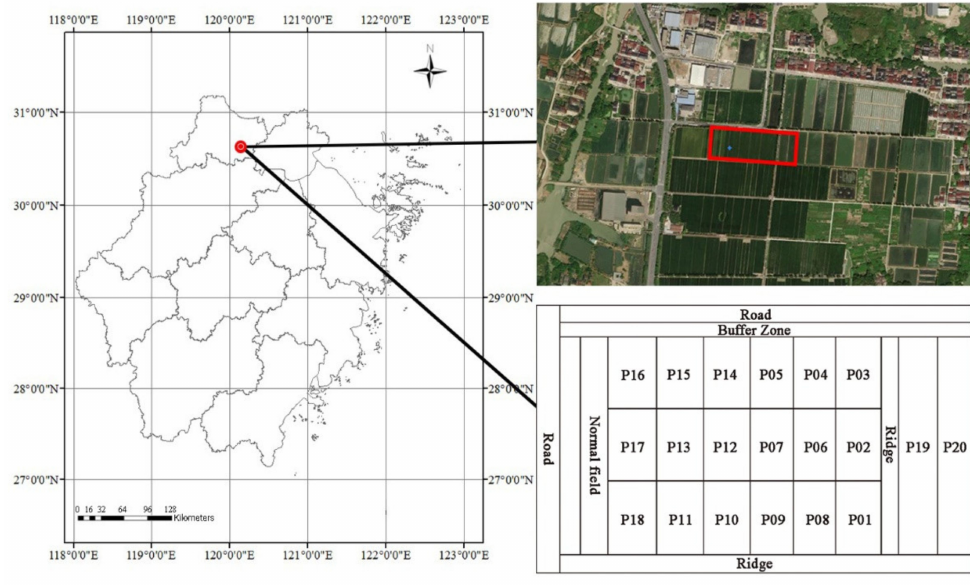
Figure 1. The general location of the field